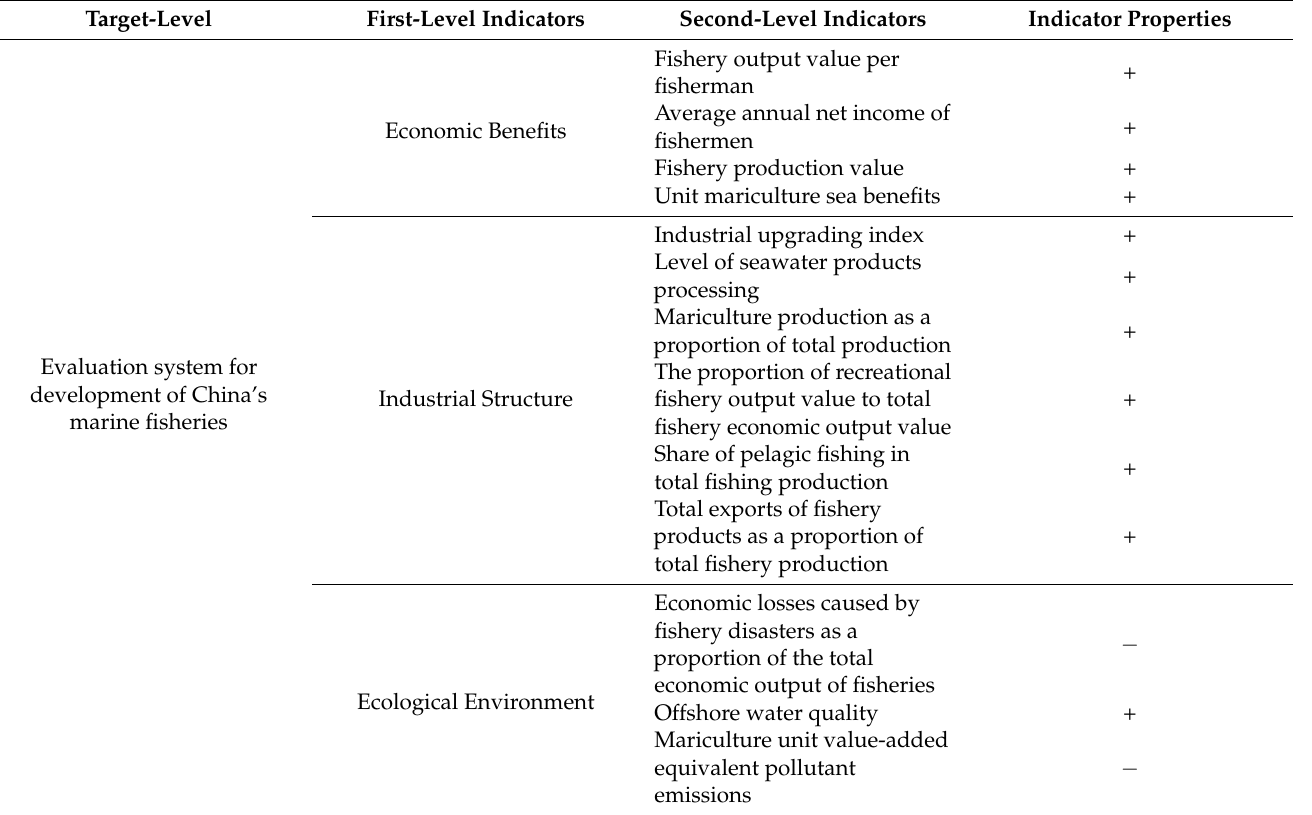
Table 1. The evaluation